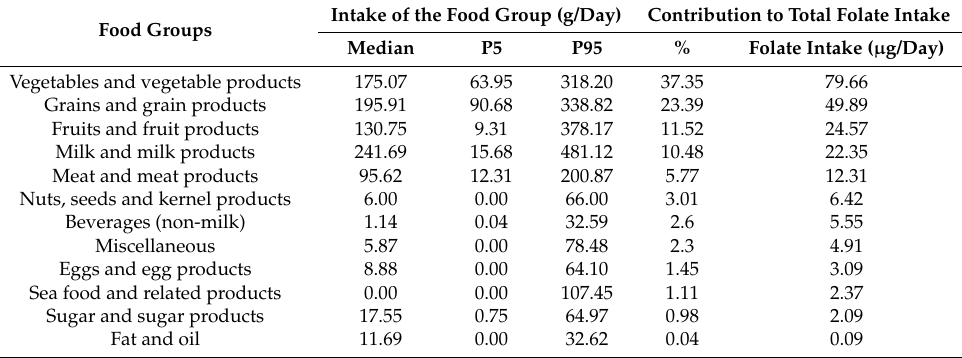
Table 2. Daily intake levels presented as the median values and 5th and 95th percentiles of twelve food groups and their corresponding contributions to daily folate intake based on repeated 24 h dietary recalls among Serbian women of reproductive age.